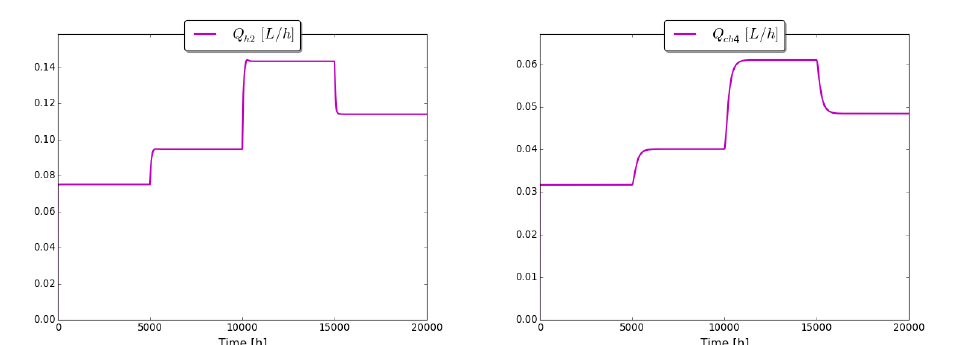
Figure 10. Time evolution of Q h 2 and Q ch 4 with variable X in c from Table 4.